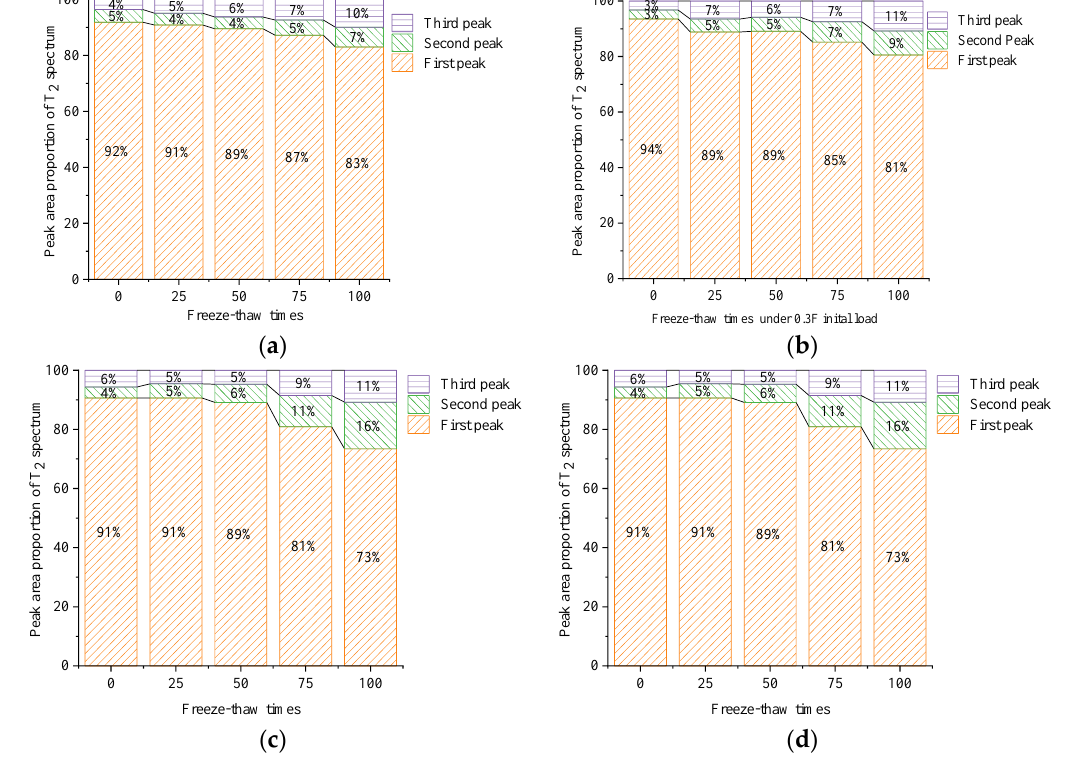
Figure 9. Peak area proportions of T2 spectra. ( a ) Freeze – thaw cycle in freshwater without an initial load. ( b ) Freeze – thaw cycle in freshwater under an initial load of 0.3 f . ( c ) Freeze – thaw cycle in a load. ( b ) Freeze–thaw cycle in freshwater under an initial load of 0.3 f . ( c ) Freeze–thaw cycle in a 6.8% composite salt solution without an initial load. ( d ) Freeze – thaw cycle in a 6.8% composite salt 6.8% composite salt solution without an initial load. ( d ) Freeze–thaw cycle in a 6.8% composite salt solution under an initial load of 0.3 f . solution under an initial load of 0.3 f